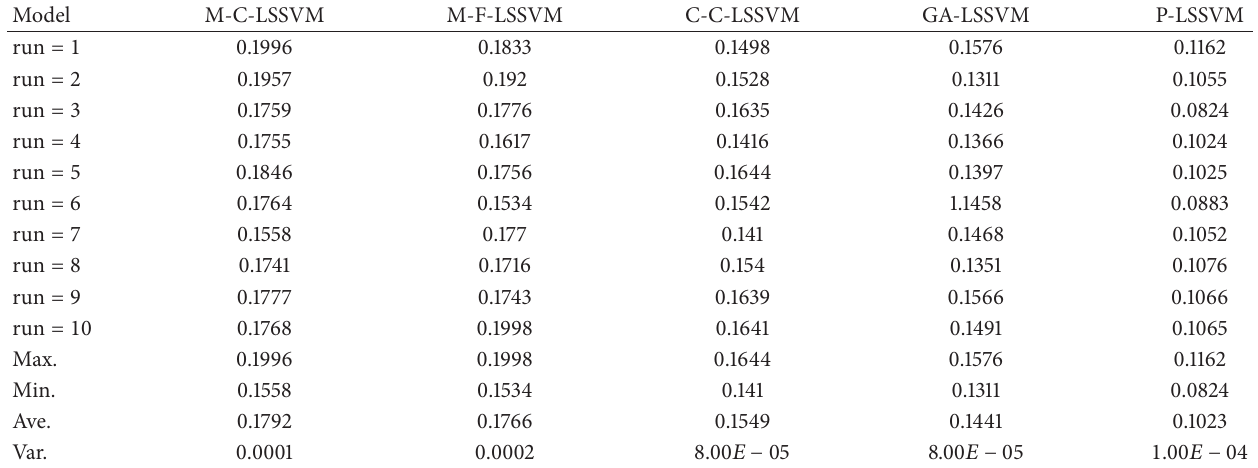
Table 9: Five models predicted error based on RMSE for FM broadcasting band.